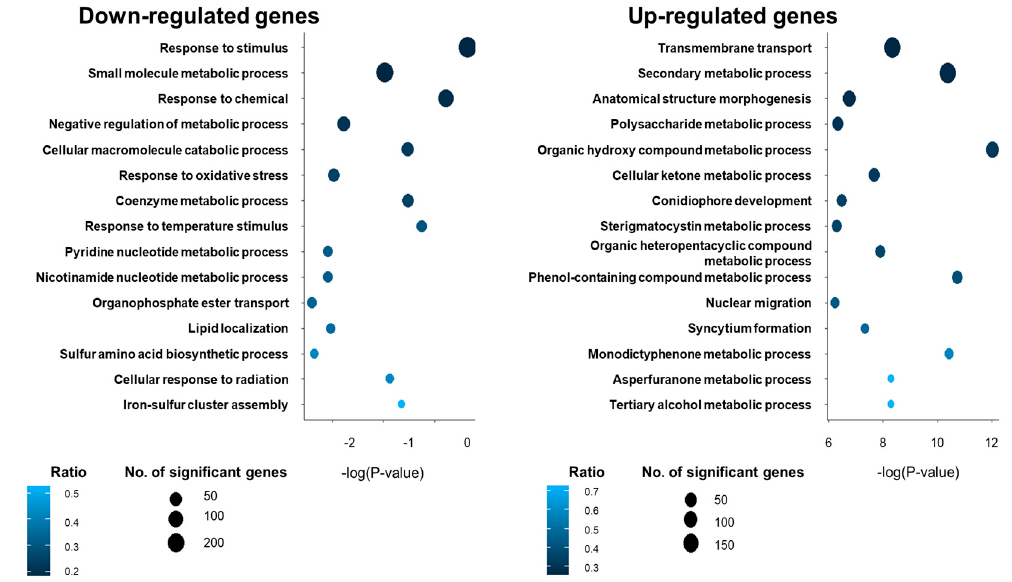
∆ vadA conidia. GO analysis of DEGs in ∆ vadA Figure 1. Transcriptomic analyses of Δ vadA conidia. GO analysis of DEGs in Δ vadA conidia. Figure 1. Transcriptomic analyses of